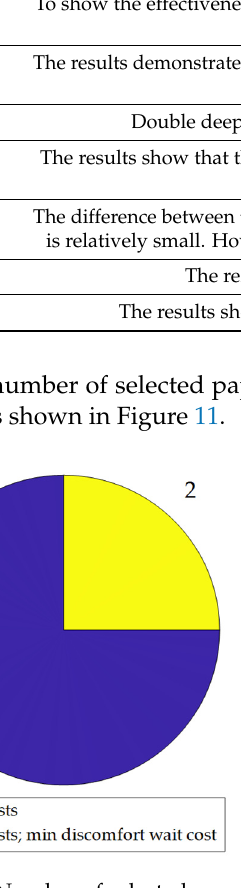
Figure 11. Number of selected papers associated with a given objective for reinforcement learning.